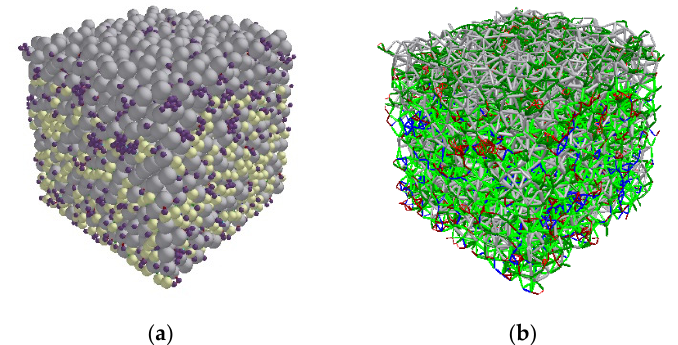
Figure 10. Bonded particle model of ore. ( a ) Particle bonding structure; ( b ) bond structure.